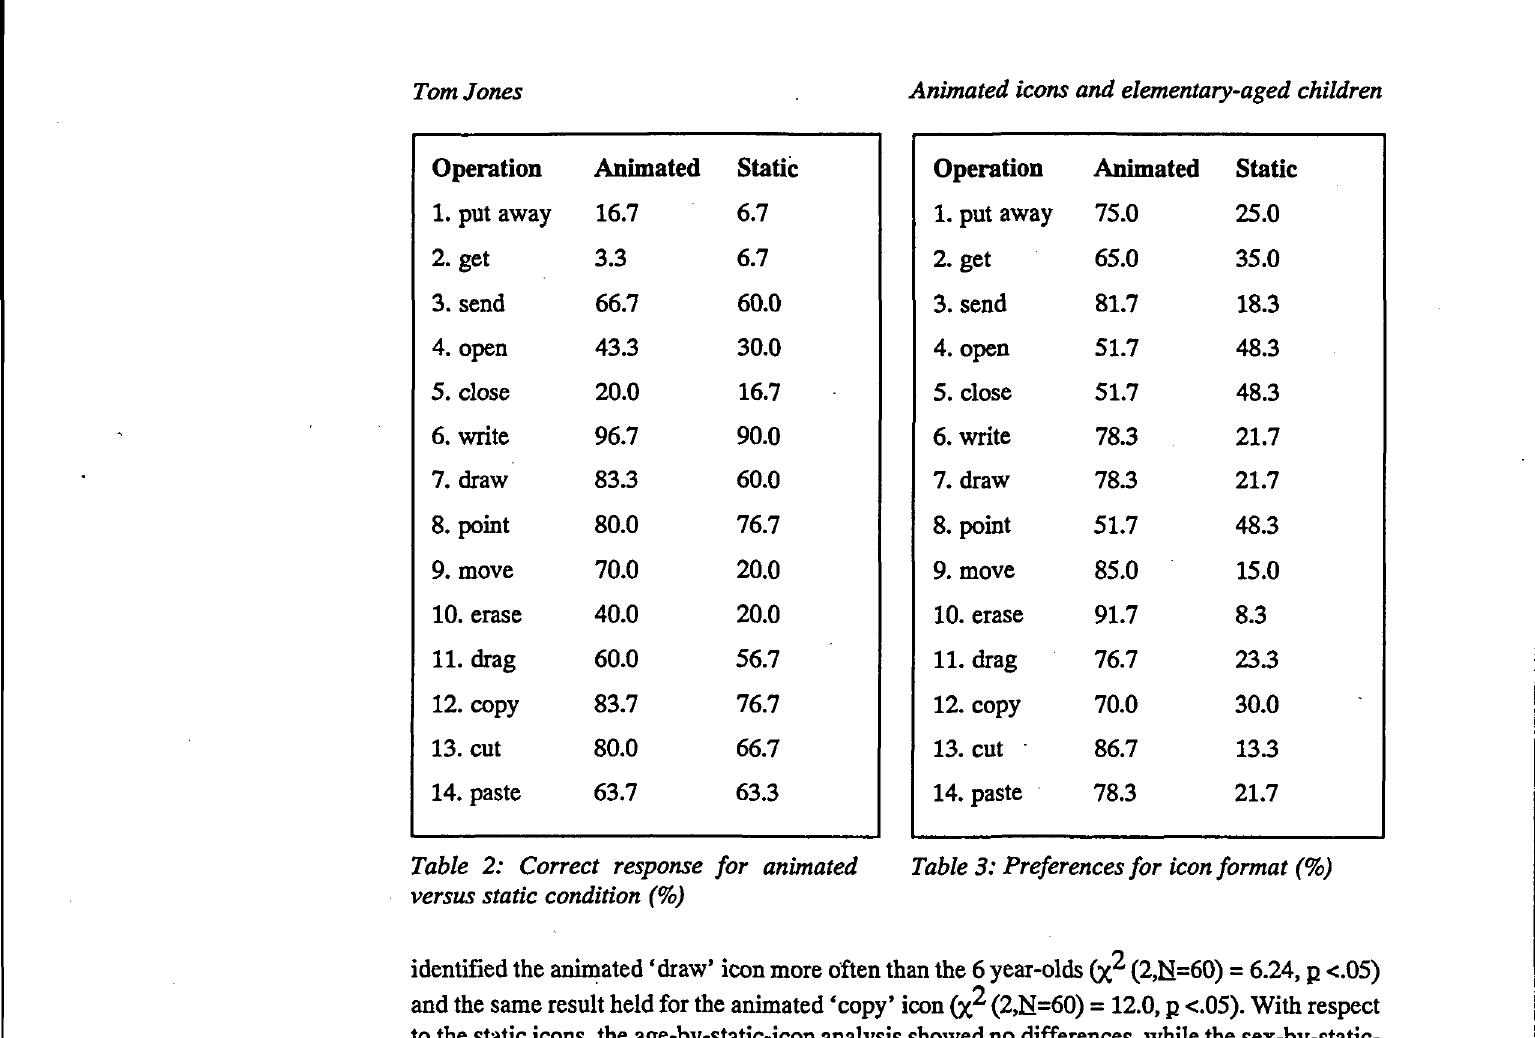
Table 2: Correct response for animated versus static condition (%)